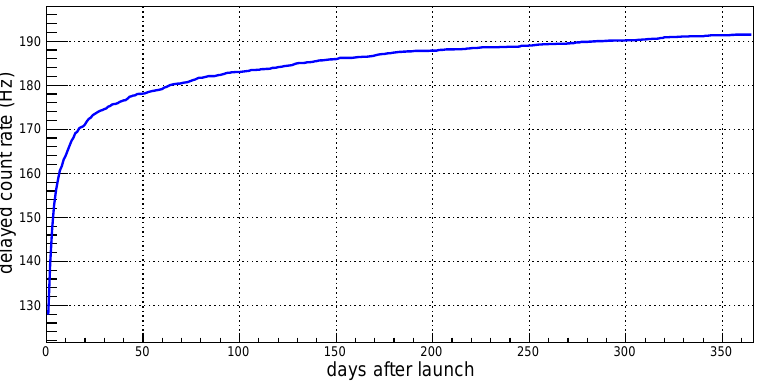
Figure 5. The accumulated distribution of the delayed background of two-hit events induced by SAA-trapped